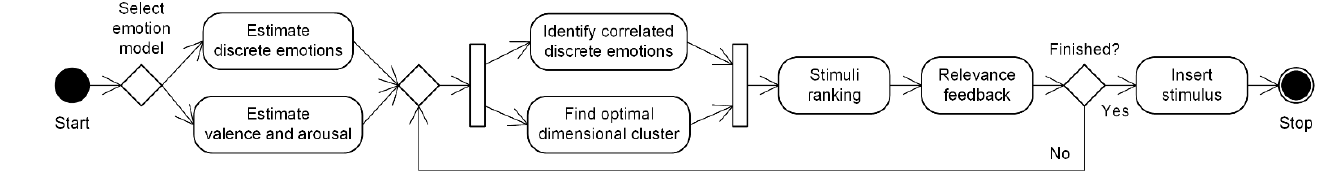
Figure 5. UML activity diagram of the proposed recommender system for iterative construction of affective picture databases using relationships between discrete and dimensional emotion models.